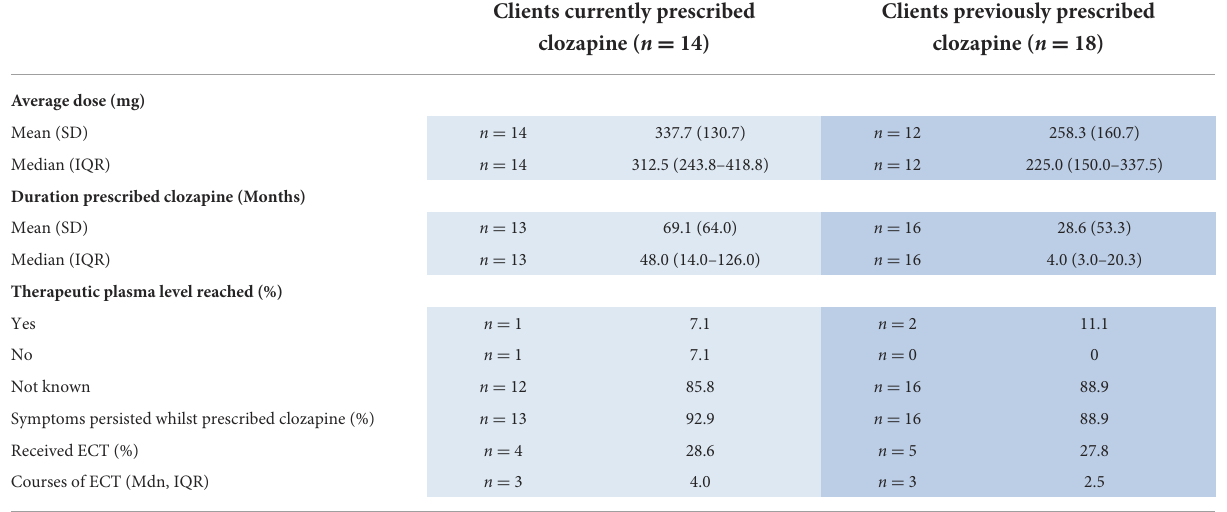
TABLE 2 Clozapine and ECT characteristics in individuals currently and previously prescribed